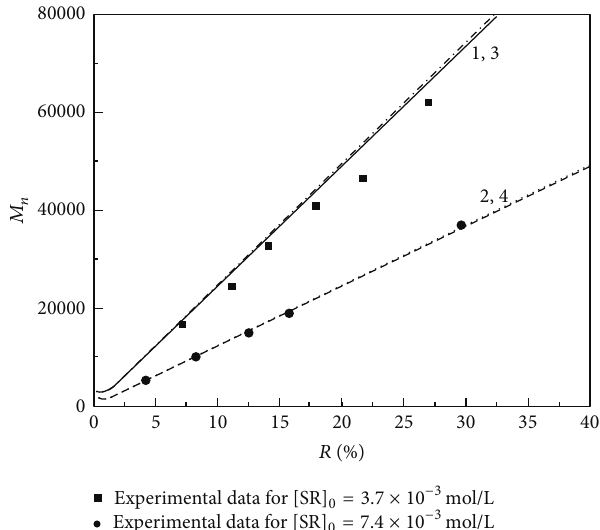
Figure 2: Dependence of 𝑀 𝑛 on conversion for styrene bulk polymerization at 90 ∘ C. The lines represent the simulated data and the dots present the experimental results. The full parameters and experimental conditions are available in